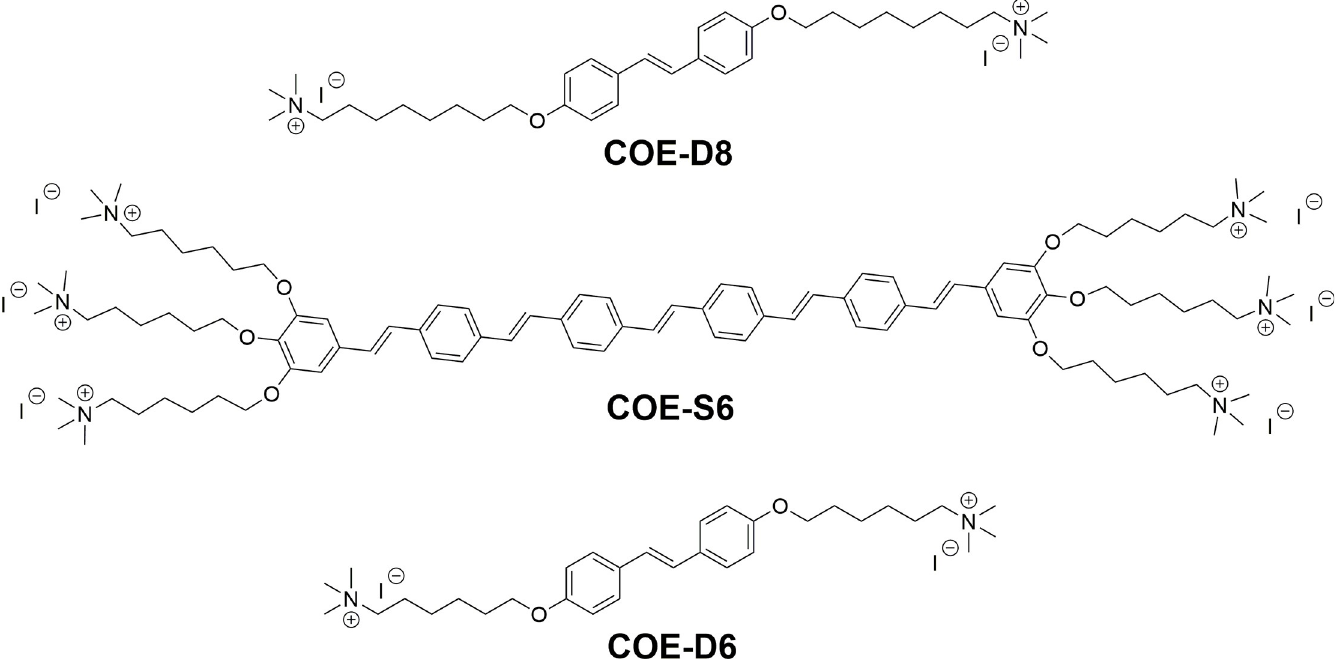
Fig 1. Chemical structures of COE-D8, COE-S6 and